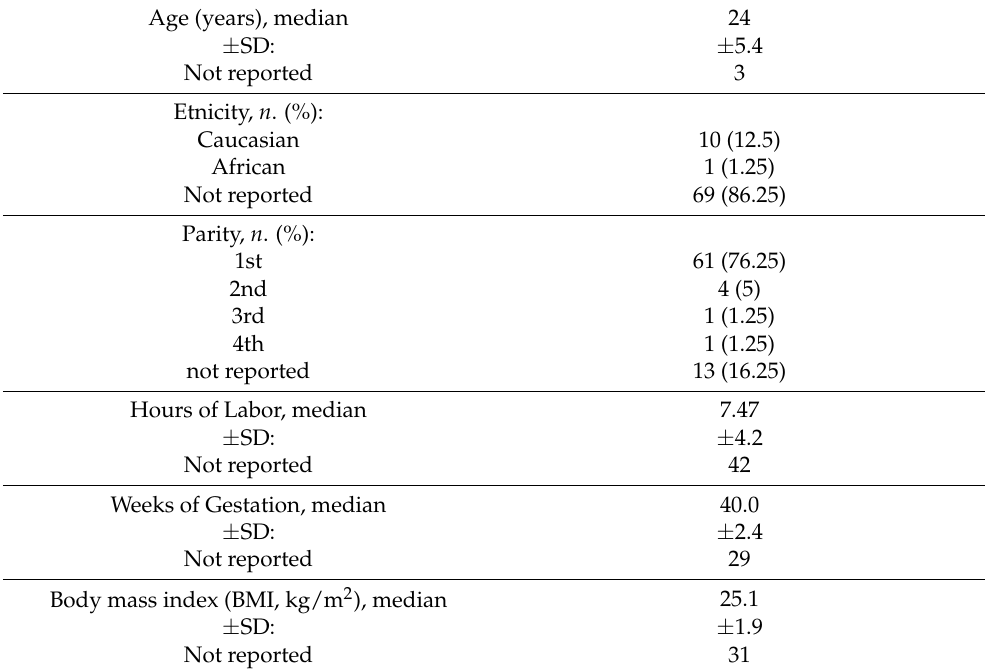
Table 1. Maternal demographic data.